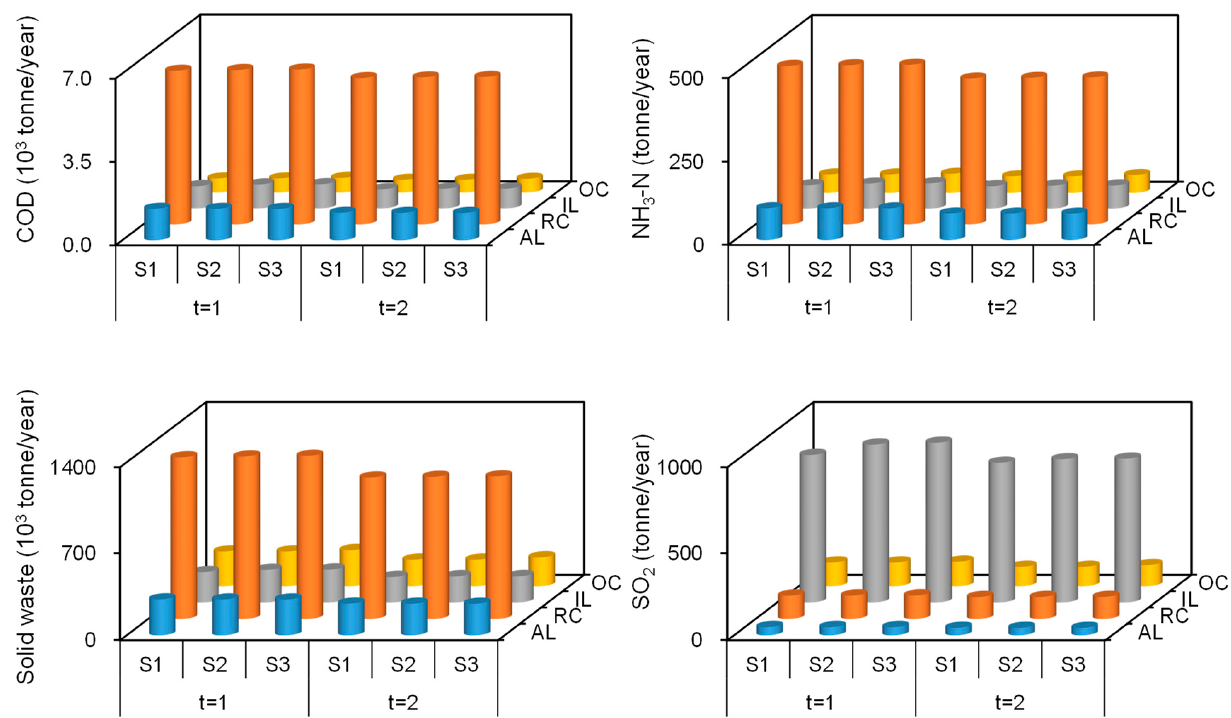
Figure 9. Pollutant emissions of human activities land. [Symbols “AL, RC, IL, and OC” denote “agricultural land, commercial and residential land, industrial land, and public land”, respectively].